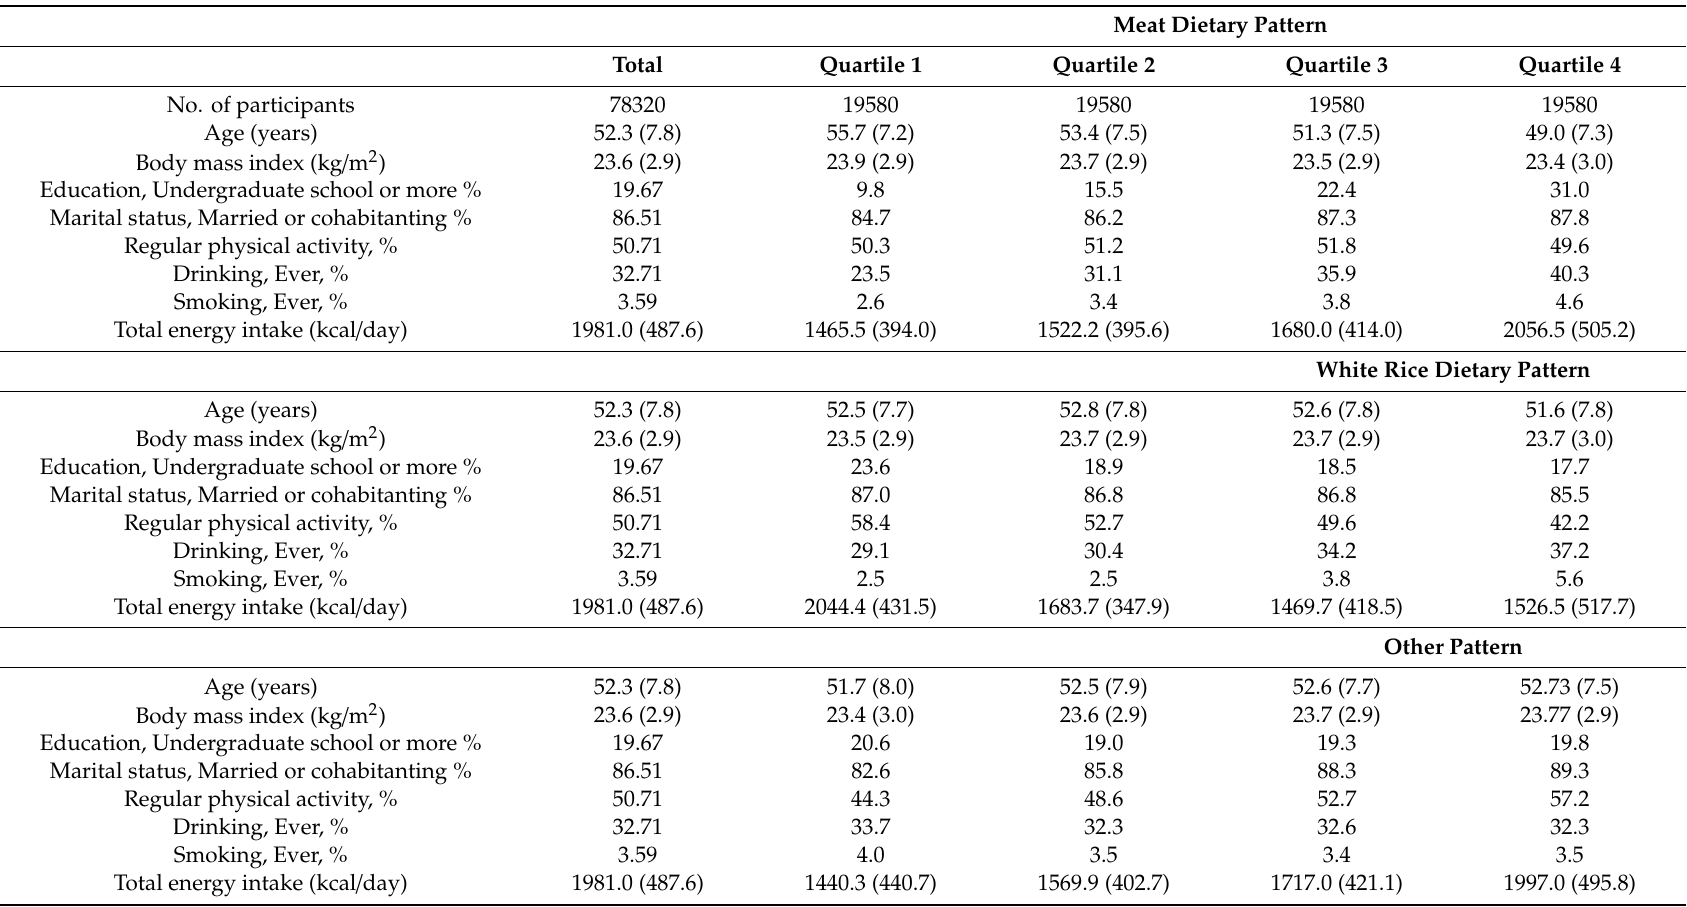
Table 3. Characteristics of Participants According to Quartiles of Each Dietary